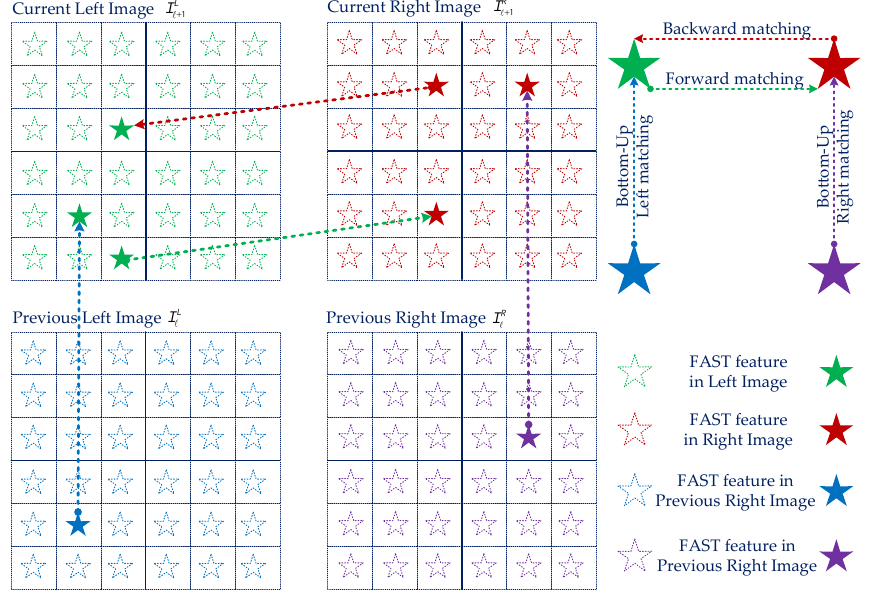
Figure 6. The demonstration of the proposed matching strategies for the stereo camera on the image plane using forward-backward-up-down tracking. The star shape represents a visual feature extracted by the FAST algorithm, and the arrow indicates the feature matching